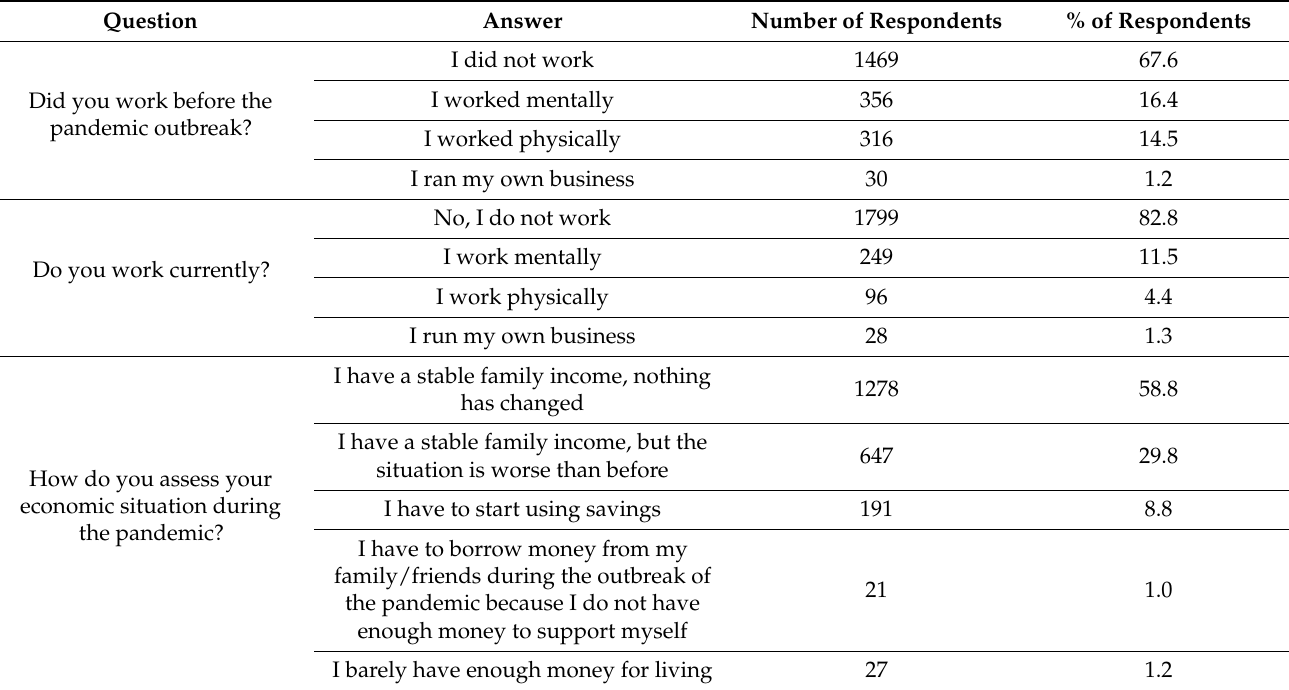
Table 4. The economic situation of the